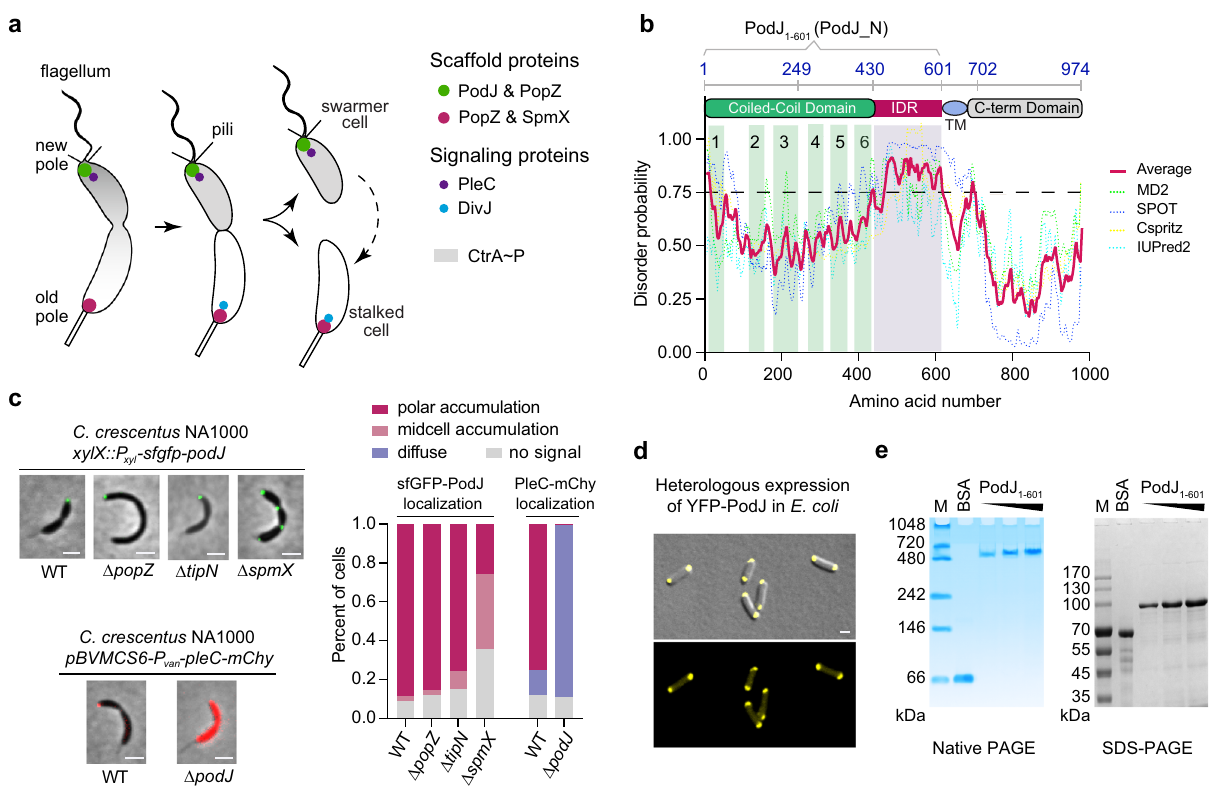
Fig. 1 | The asymmetrically localized PodJ is a self-assembled protein. a Schematicofasymmetriccelldivisionof C.crescentus .ThescaffoldsPodJ-PopZat the swarmer cell pole and PopZ-SpmX at the stalked cell pole recruit distinct sig- naling proteins,suchasPleCand DivJ, respectively.Aftercelldivision,theswarmer cells develop into a stalked cell, which iscorrelated with the remodeling ofthe cell pole from a PodJ-rich signaling hub to an SpmX-rich signaling hub. b Detection of an intrinsically disordered region (IDR) in PodJ. The probability of IDR is repre- sented as average scores (red line) calculated by Metadisorder MD2 59 , SPOT 60 , Cspritz 61 ,and IUPred2 62 .Domainpredictionwasadaptedfrompreviousstudies 15,19 .